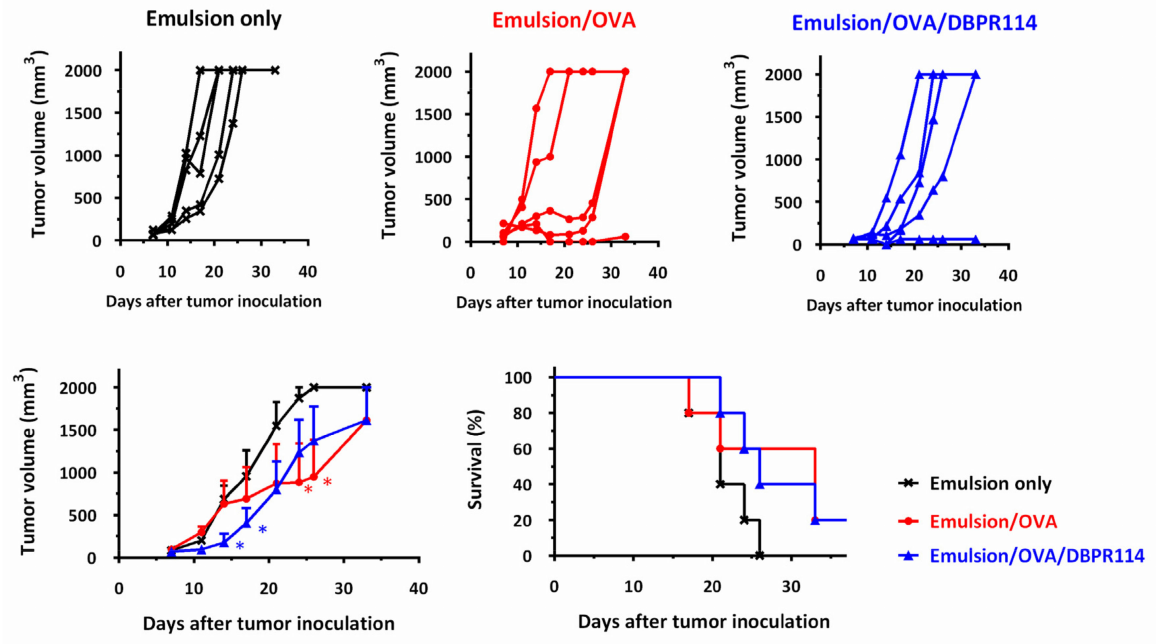
Figure 2. Antitumor efficacy of co-delivery of OVA/DBPR114 to C57BL/6 mice bearing EG7 tumor cells. Mice were inoculated s.c. in the flank with EG7 tumor cells (2 × 10 5 cells/mouse). Upon the appearance of palpable tumors, five mice per group were treated with emulsion alone or emulsion formulated with OVA protein in the absence or presence of DBPR114 micelles. Tumor volumes in tumor-bearing mice were monitored twice per week and recorded individually. The mice were euthanized when the tumor volume was larger than 2000 mm 3 . The data are expressed as the mean value with standard error of the mean. The tumor volumes were compared by performing a Student’s t -test. * p < 0.05 compared with the group of emulsions